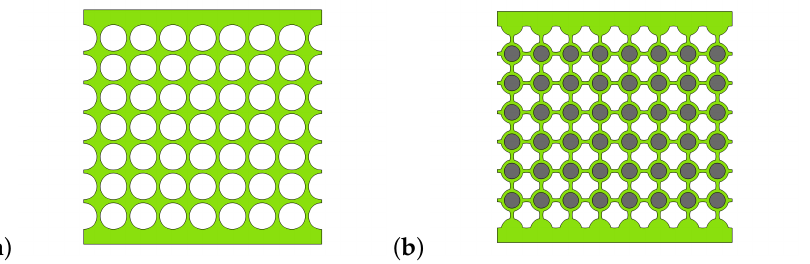
Figure 5. Finite structures designed from 8 × 7 ( a ) S 0 cells and ( B ) S R cells.